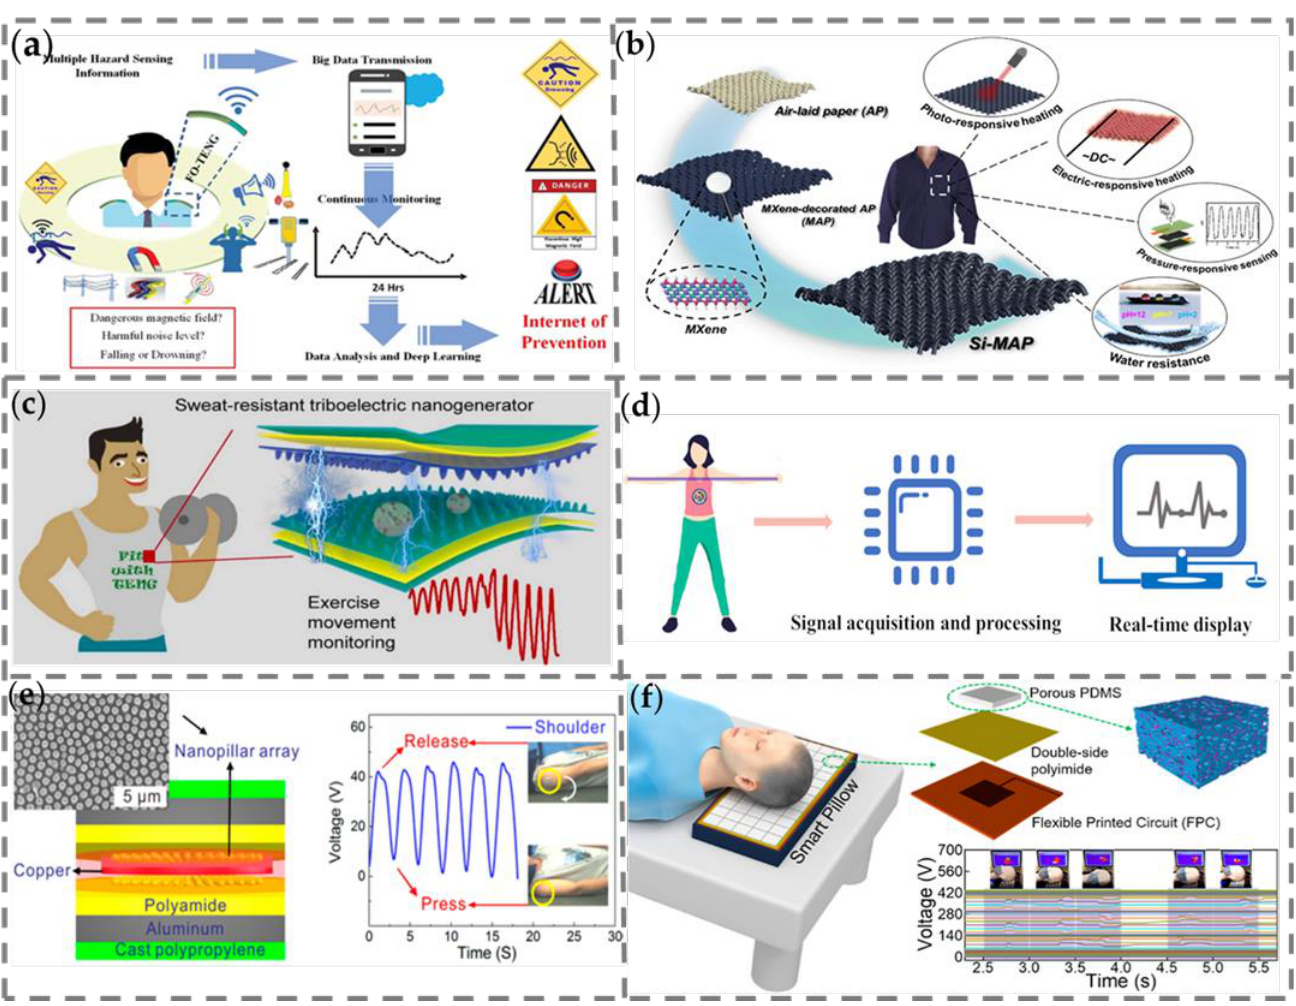
Figure 12. ( a ) Hazard preventive wearable platform. Different forms of mechanical force are typically obtained by the human body or induced externally by magnetic or acoustic fields [112]. Copyright 2019, WILEY-VCH VERLAG GMBH ( b ) Schematic illustration of the preparation process of the hydrophobic MXene-decorated fabrics [113]. Copyright 2020, AMER CHEMICAL SOC. ( c ) Schematic structure of the BSRW-TENG [114]. Copyright 2022, ELSEVIER. ( d ) Real-time demonstration process in the actual